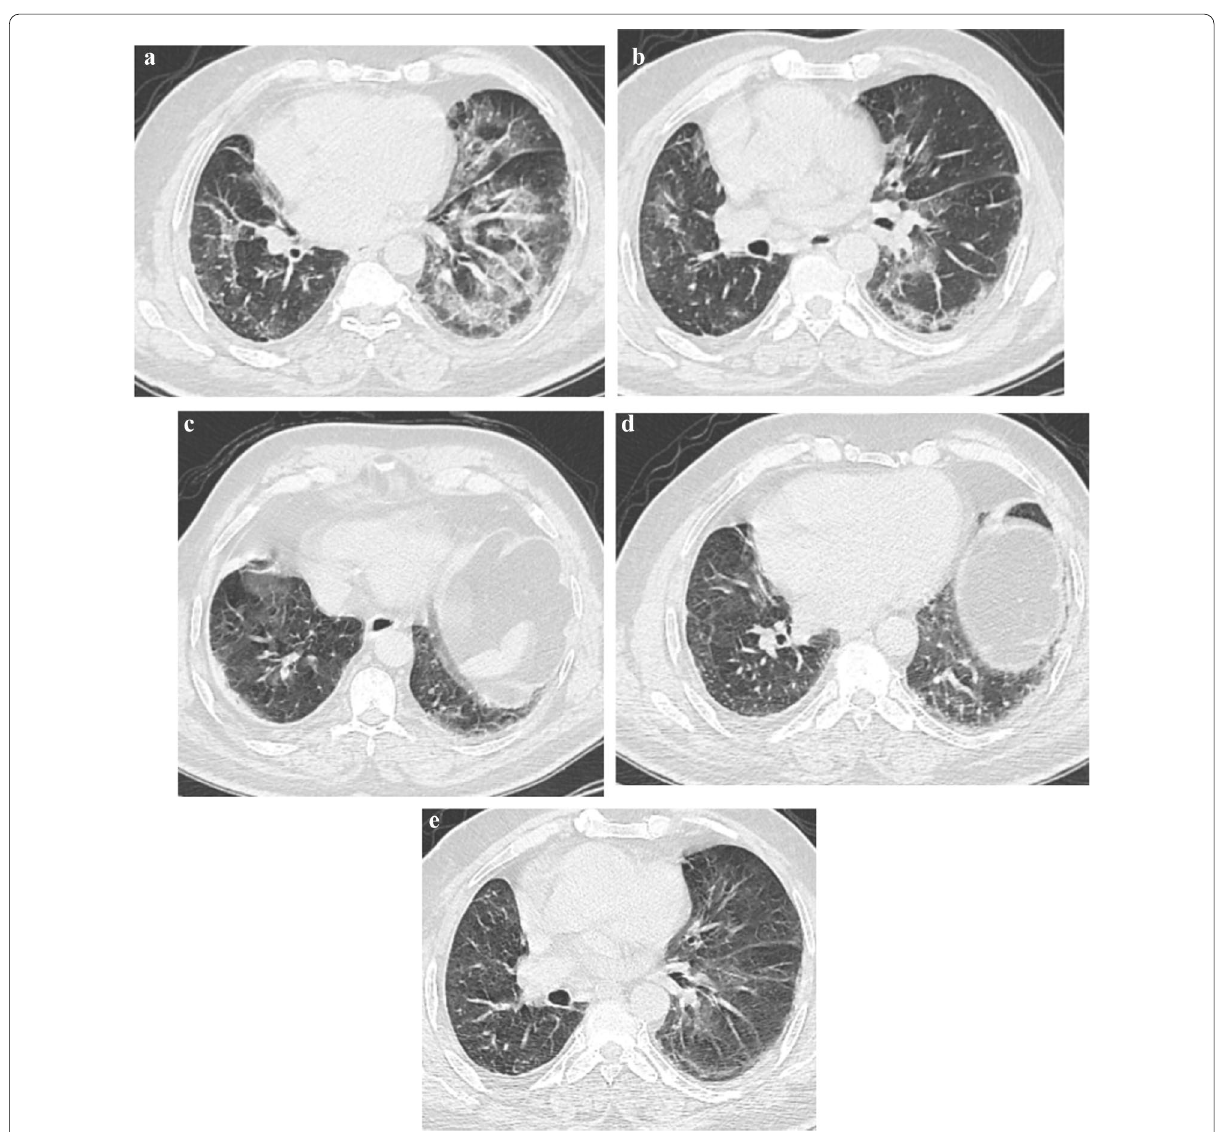
Fig. 4. A 65-year-old female known IHD presented with anosmia, loss of taste, cough, fever, respiratory distress, diarrhea and myalgia at May 2020 and positive PCR for COVID 19 infection, a and b noncontrast CT axial cuts show bilateral faint ground glass opacities with crazy paving sign. The patient diagnosed as COVID 19 infection with CT score severity: 20. Second infection dated May 2021 the patient presented with fever, diarrhea and myalgia with positive PCR test for COVID 19 infection. c – e noncontrast CT chest images show bilateral patchy subpleural faint ground glass opacities and reticulations. The patient diagnosed as COVID 19 re-infection with CT severity score: 5